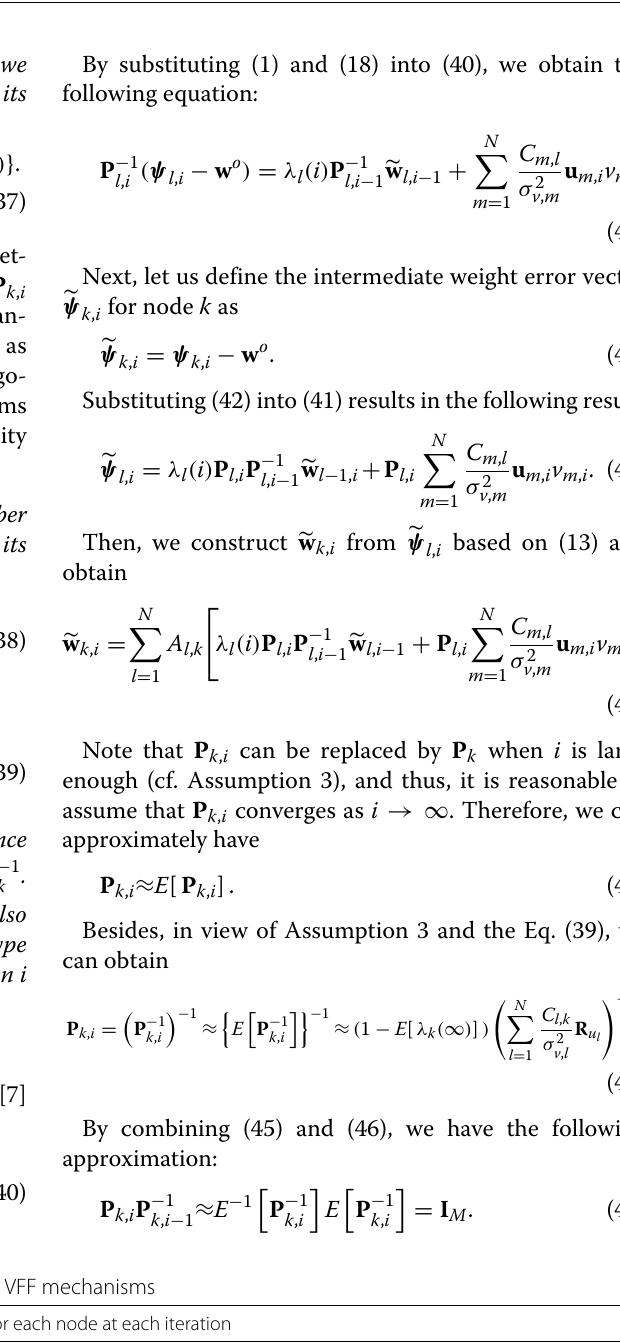
Table 2 Computational complexity of the DRLS algorithm Number of operations for each node at each iteration Multiplications Additions DRLS (fixed forgetting factor) M 2 + N 2 ( 4 M 2 + 5 M + 1 ) + M